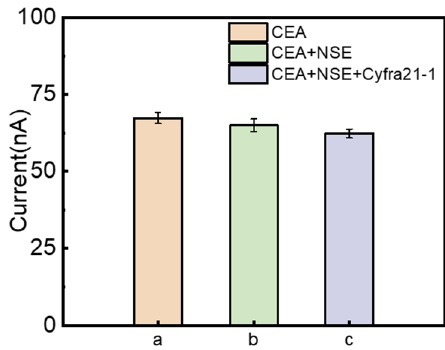
( f ) Figure 6. The signal responses of proposed immunosensor at different ( a ) CEA, ( c ) NSE, and ( e ) Cyfra21-1 concentrations. Linear relationship between the DPV peak current change and the loga- rithm of the concentrations of ( b ) CEA, ( d ) NSE, ( f ) Cyfra21-1. 3.4.2. Selectivity Normal samples often contain a high abundance of non-target proteins that can po- tentially interfere with exosome detection and lead to inaccurate results. In order to eval- uate the anti-interference ability of the electrochemical immunosensor, anti-CEA was modified on the working electrode, and equal concentrations of interfering substances